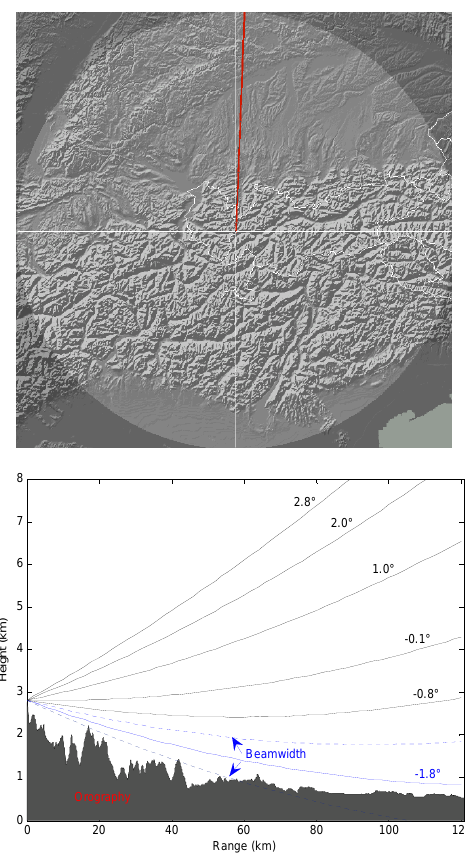
Fig. 1. (a) Location of the Valluga weather radar (in the center of the crosslines) (b) Beam height above mean sea level over range for different elevation angles. The orography profile is given for the red line in (a).